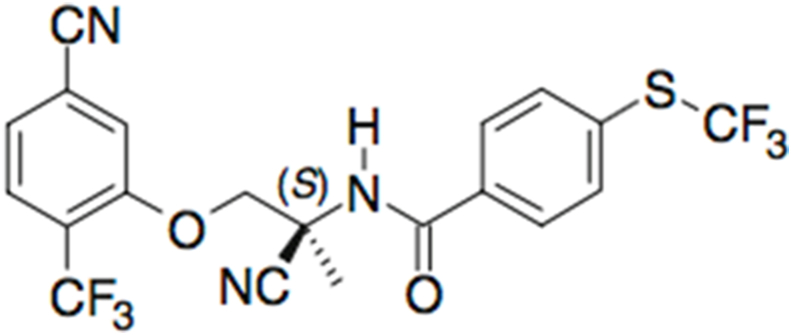
Chemical structure of monepantel [N-[(2S)-2-cyano-1-[5-cyano-2-(trifluoromethyl)phenoxy]propan-2-yl]-4-(trifluoromethylsulfanyl)benzamide].